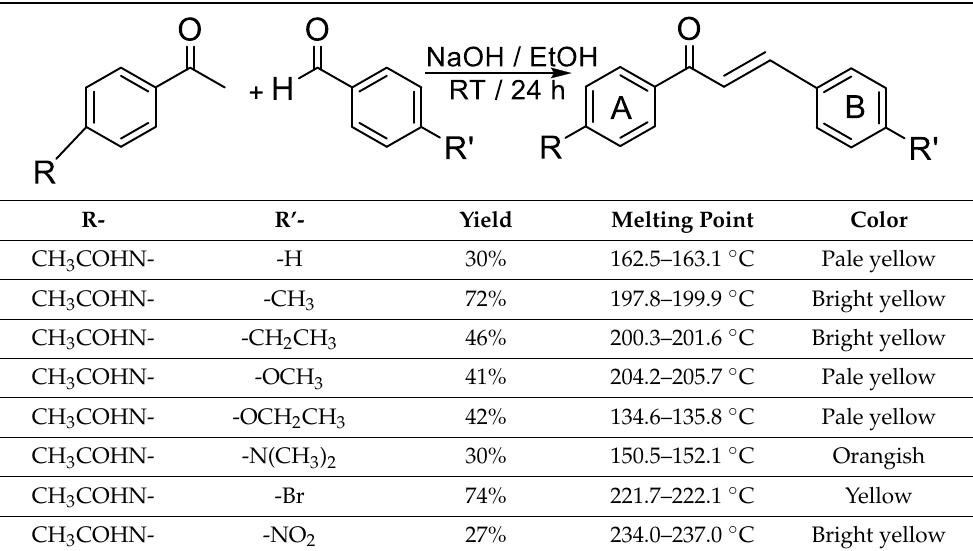
Table 3. Acetamide-chalcone derivatives synthesized by Claisen-Schmidt condensation and the reaction yield, melting points, and visual colors of products. The benzene ring linked to the aceto- amide group was named ring A, and the one with peripherical groups was named ring B.